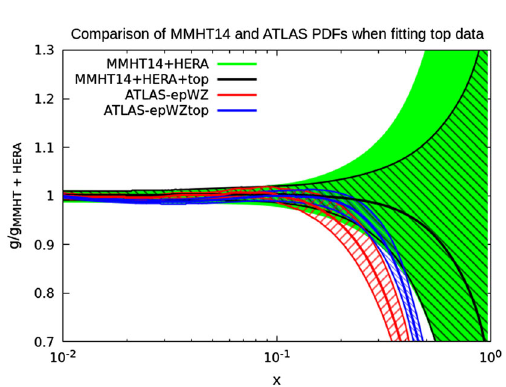
Fig. 11 Impact of the ATLAS default combination on the MMHT14 and ATLAS-epWZ [33] PDF